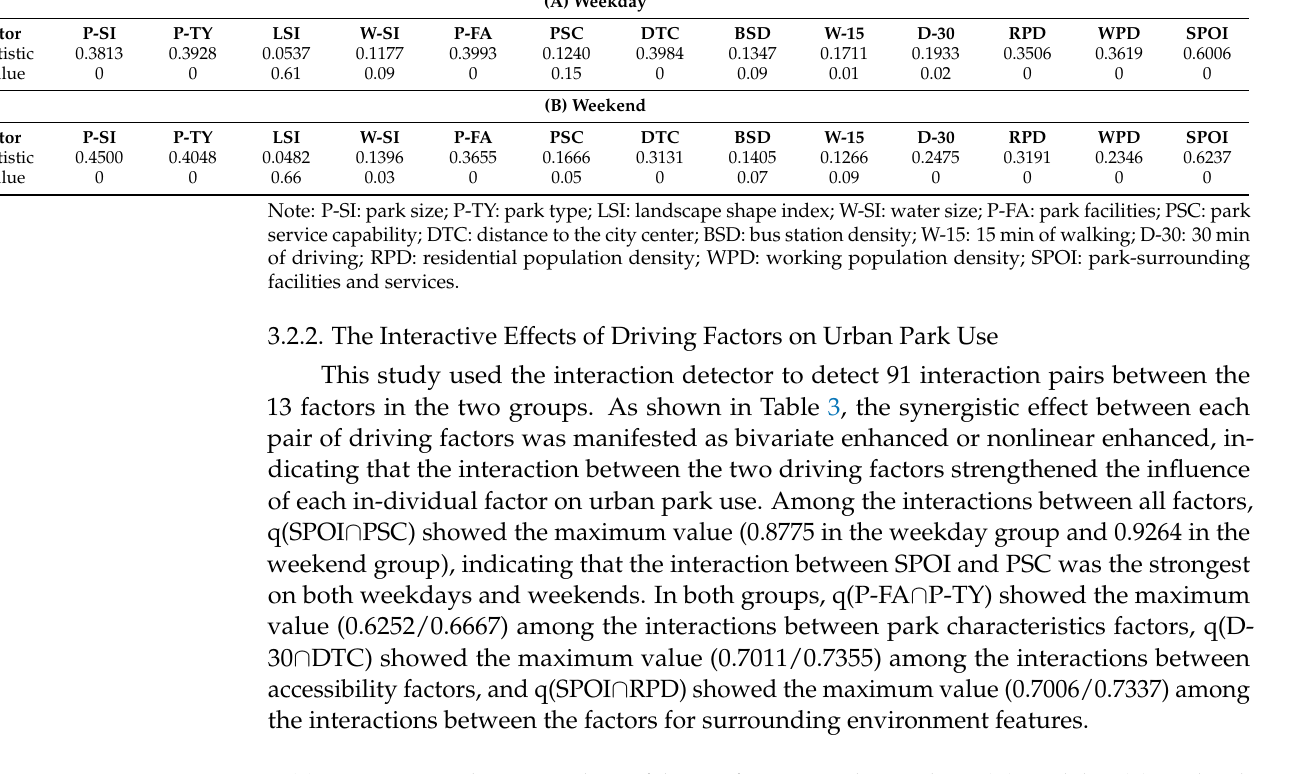
Table 3. Interaction detector analysis of driving factors on urban park use (A) Weekday; (B)